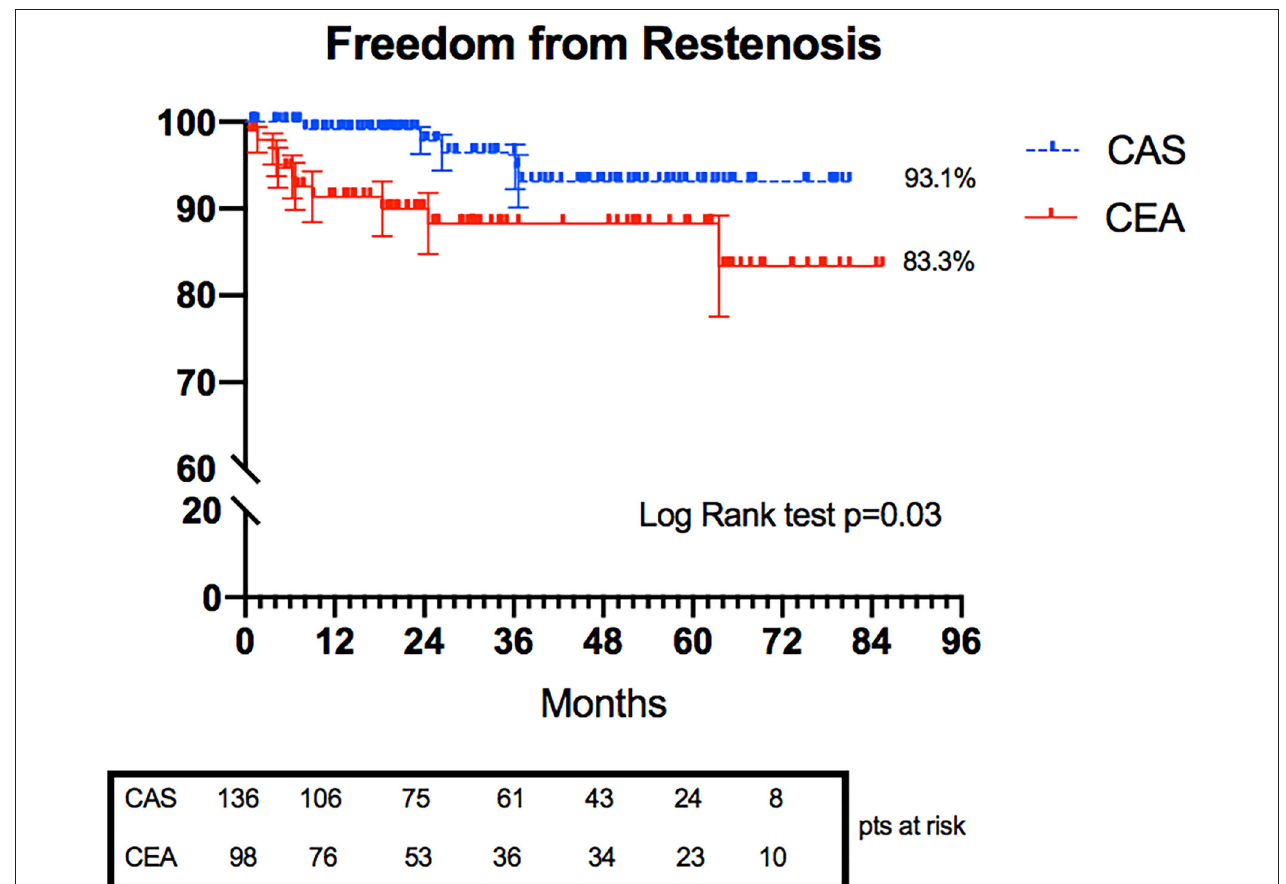
FIGURE 3 | Kaplan–Meier curves representing freedom from restenosis in CAS and CEA